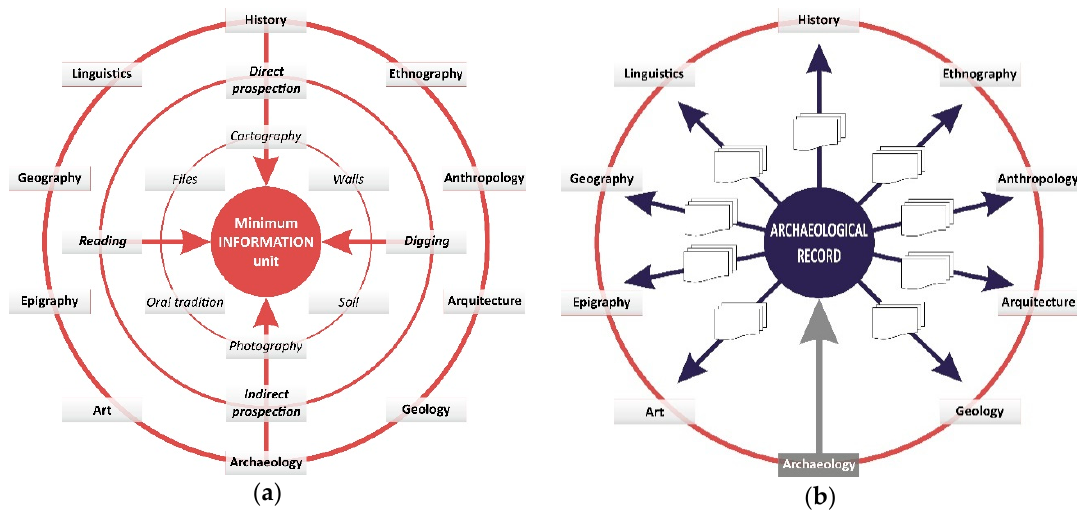
Figure 3. Exchangeable information management scheme. Different disciplines—regardless of whether they share the SSH domain or not—have their own research methods, which are comparable as long as they share minimum information units ( a ). When this happens, a new interdisciplinary scenario allows the common use and exploitation of both vestiges and reflections according to archaeology ( b ).